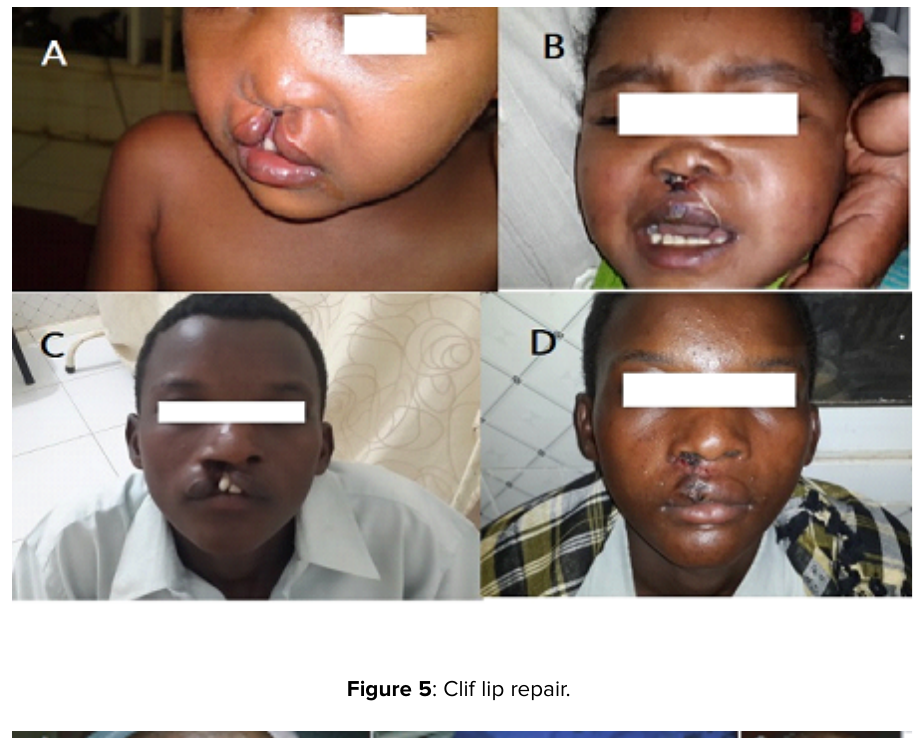
Figure 5 : Clif lip repair.